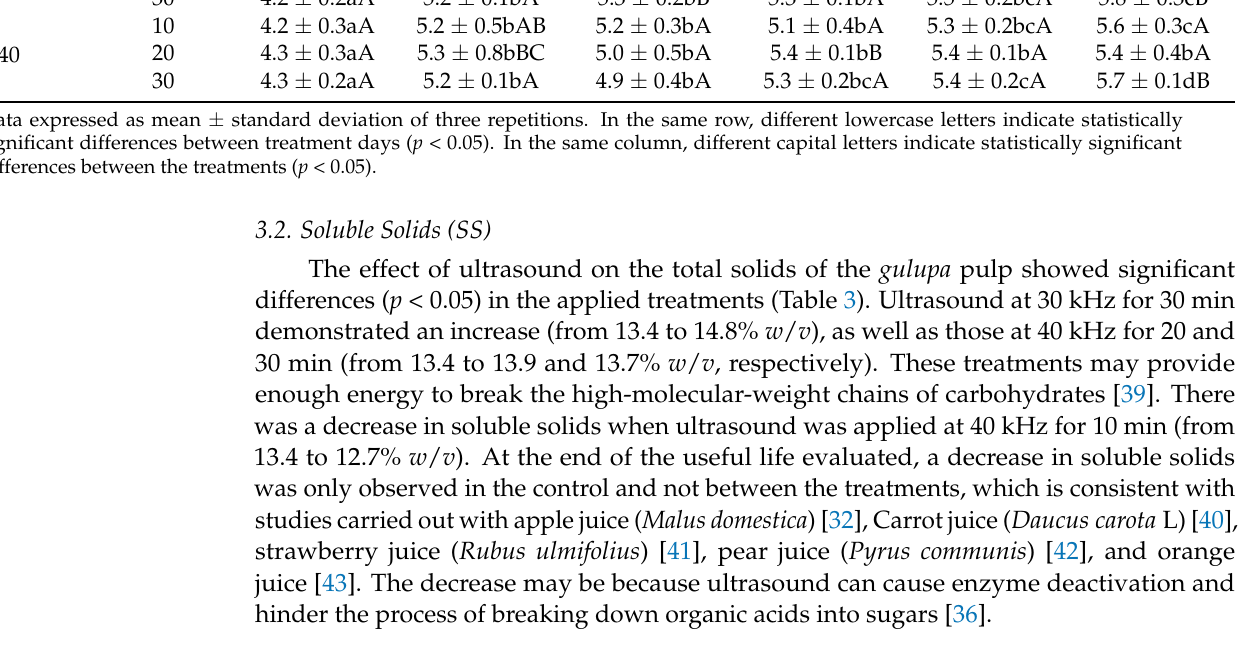
Table 3. Soluble solids (% w / v ) during storage at 4 ◦ C of Passiflora edulis f. edulis Sims ( gulupa ) pulp subjected to low- frequency ultrasound treatments.